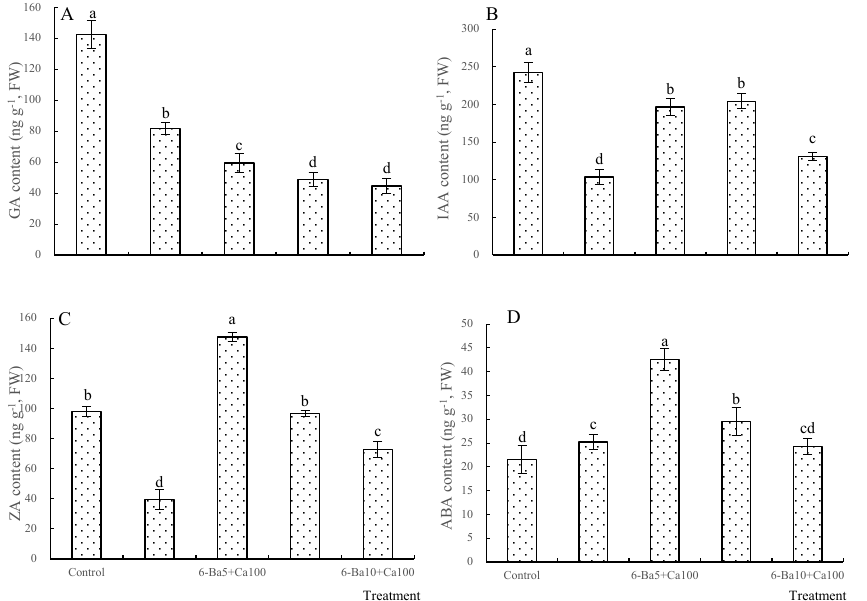
Figure 2. Changes of leaf-endogenous hormone contents of Hangbaiju. GA content ( A ), IAA content ( B ), ZA content ( C ) and ABA content ( D ). Control: water + decapitation; 6-BA 5 + Ca 50 : 5 mg/L 6-BA + 50 mg/L Pro-Ca; 6-BA 5 + Ca 100 : 5 mg/L 6-BA + 100 mg/L Pro-Ca; 6-BA 10 + Ca 50 : 10 mg/L 6-BA + 50 mg/L Pro-Ca; 6-BA 10 + Ca 100 : 10 mg/L 6-BA + 100 mg/L Pro-Ca. Different letters indicate significant differences ( p < 0.05) according to the Tukey’s test. The error bars represent the standard error of the mean (n = 5).